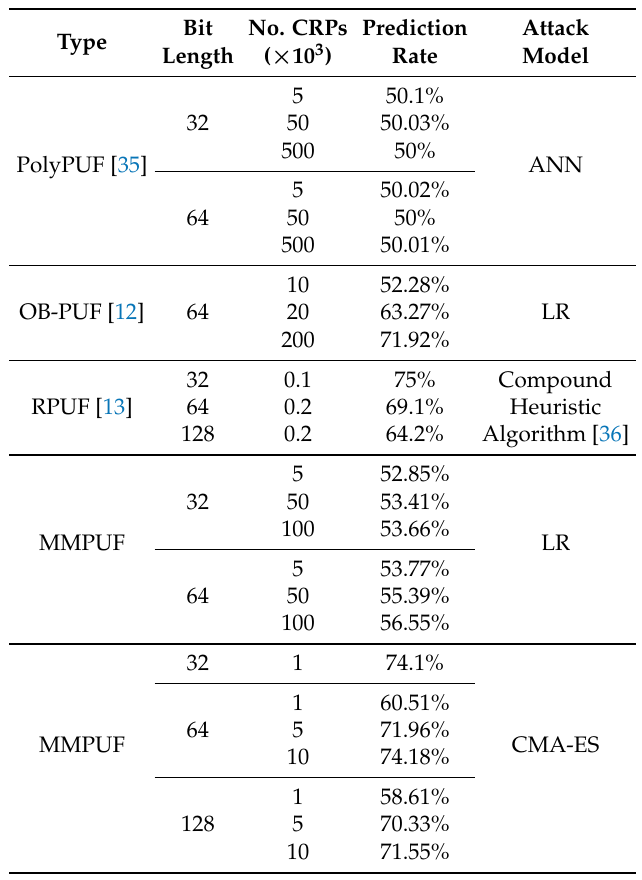
Table 3. Comparison of Attacks between Different Types of PUF